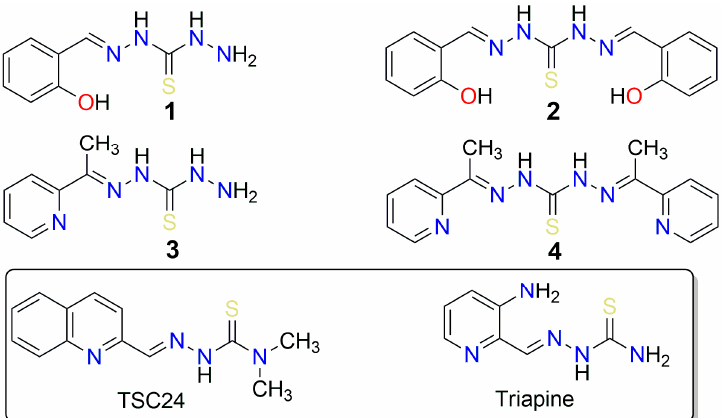
Figure 1. Structures of thiocarbohydrazones 1–4 investigated in this study, along with structurally similar thiosemicarbazones (triapine) that possess anticancer properties, and TSC24, which additionally inhibits the human DNA topoisomerase II α .